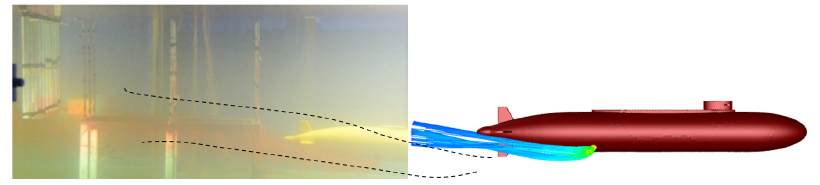
Figure 11. Comparison of thermal wake trajectory.